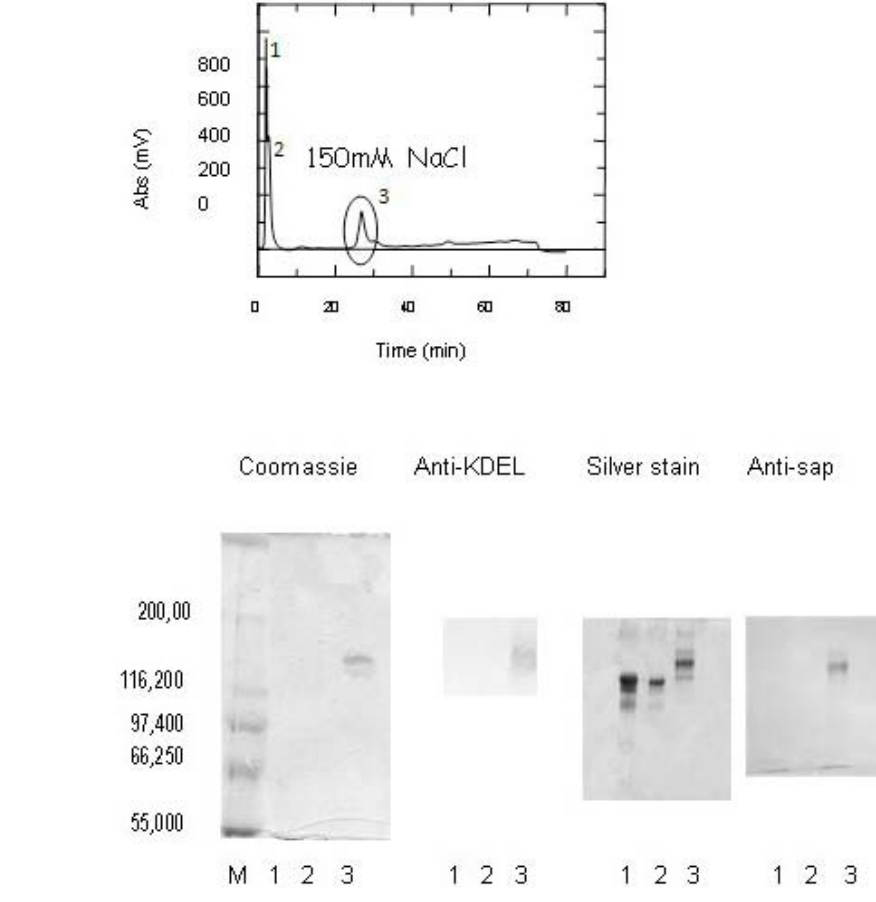
Figure 2. ( A ) ion-exchange chromatographic purification of CD7-SAP 3rd fraction marked by the circle corresponds to a 150 mM NaCl concentration in the linear gradient used for elution. This fraction is reported as sample 3 in the SDS-PAGE and blot analysis. ( B ) SDS-PAGE analysis of fractions obtained from the ion-exchange chromatography. Samples 1 and 2 correspond to the first peaks appearing in the elution gradient (see Panel A). The samples were stained either by Coomassie-blue or by silver staining, or analysed by western blotting using a monoclonal anti-KDEL or a polyclonal anti-SAP